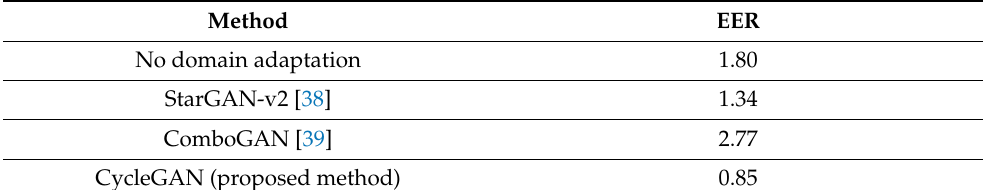
Table 7. Comparisons of EERs of the proposed method and other domain adaptation methods in case of training with SDUMLA-HMT-DB and testing with HKPolyU-DB (unit: %).